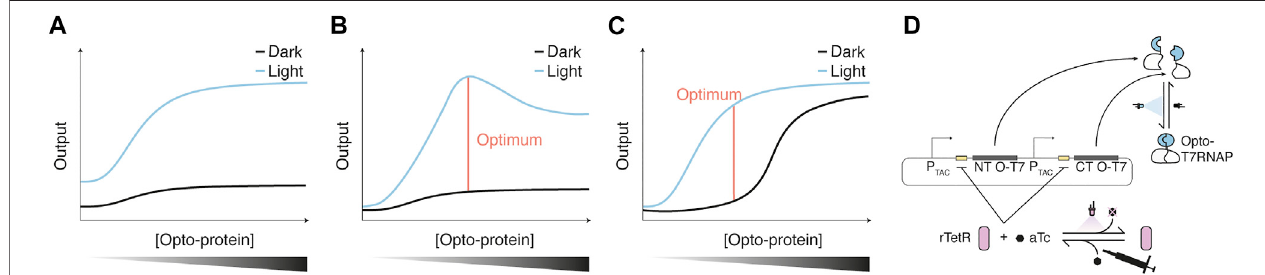
FIGURE 3 | Optimization of Opto-protein concentration (A – C) Potential scenarios encountered for light-induced and dark-state output/activity obtained with increasingOpto-proteinconcentrations.Optimalregulatorexpressionisde fi nedasthefoldchangeofdarktolight-inducedreporterexpression.Inscenarioone (A) ,dark and light-induced output increase proportionally,therefore thefoldchangeismaintainedforvarious regulatorconcentrations.Scenariostwo (B) and three (C) showtwo examples in which the fold change is maximal at speci fi c Opto-protein concentrations. Scenario two could be caused by the burden of the regulator expression which could lead to a reduction of the output, while in scenario three, a high regulator concentration might lead to increased dark state activation due to, for example, molecular crowding. (D) The concentration of the Opto-protein can also be adjusted throughout an experiment/biological process via a dual control scheme as shown for the Opto-T7RNAP, whose expression was controlled through the repressor rTetR (Baumschlager et al., 2020). rTetR binds tetO operator sequences of a corresponding promoter with anhydrotetracycline (aTc) bound, which represses transcription of the Opto-protein regulator. aTc can be inactivated with UVA light, leading to an induction of Opto-T7RNAP expression, which in turn can be activated with blue light. This regulation scheme was used to reduce the dark state activity of Opto-T7RNAP in the presence of